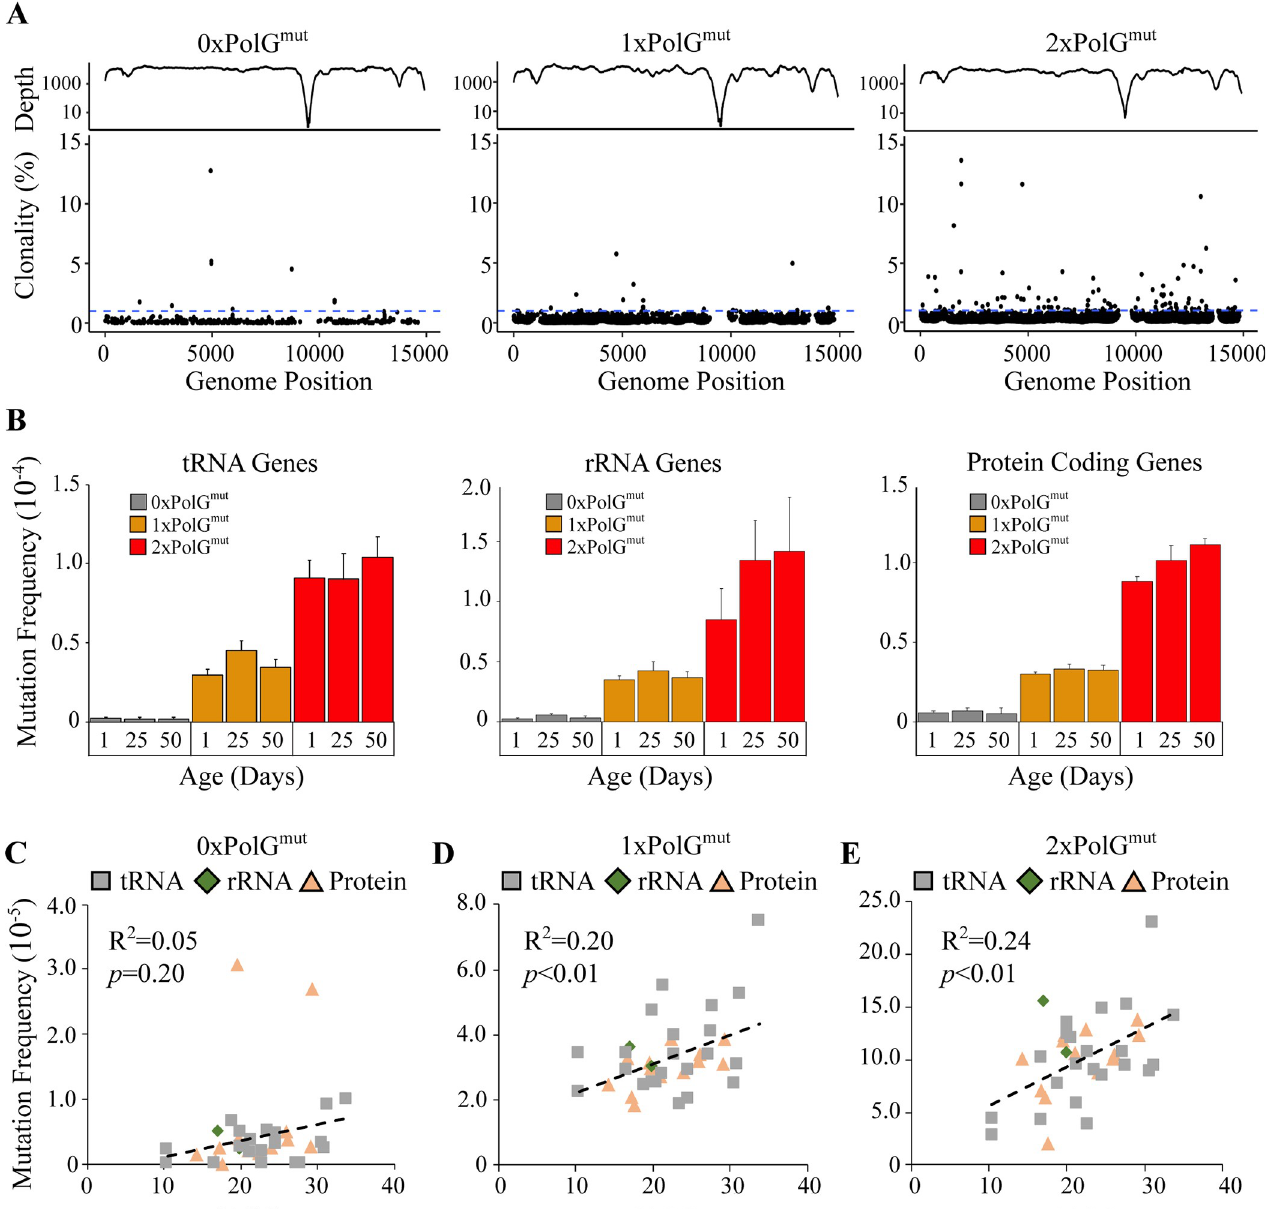
Fig 3. Mutation frequency is relatively uniform across the mitochondrial genome. (A) Sequencing depth (log 10 -transformed y-axis) and percent heteroplasmy of mutations across the mitochondrial genome in flies of all ages for the indicated genotype. 1% heteroplasmy is indicated by the dashed blue line. (B) Mutation frequency of mitochondrial tRNAs, rRNAs and protein coding genes for flies of the given genotype and age are shown. The correlation between GC content and mutation frequency in (C) tRNA, (D) rRNA, and (E) protein coding sequences for flies of all ages in the genotypes indicated. p -value was determined by Pearson